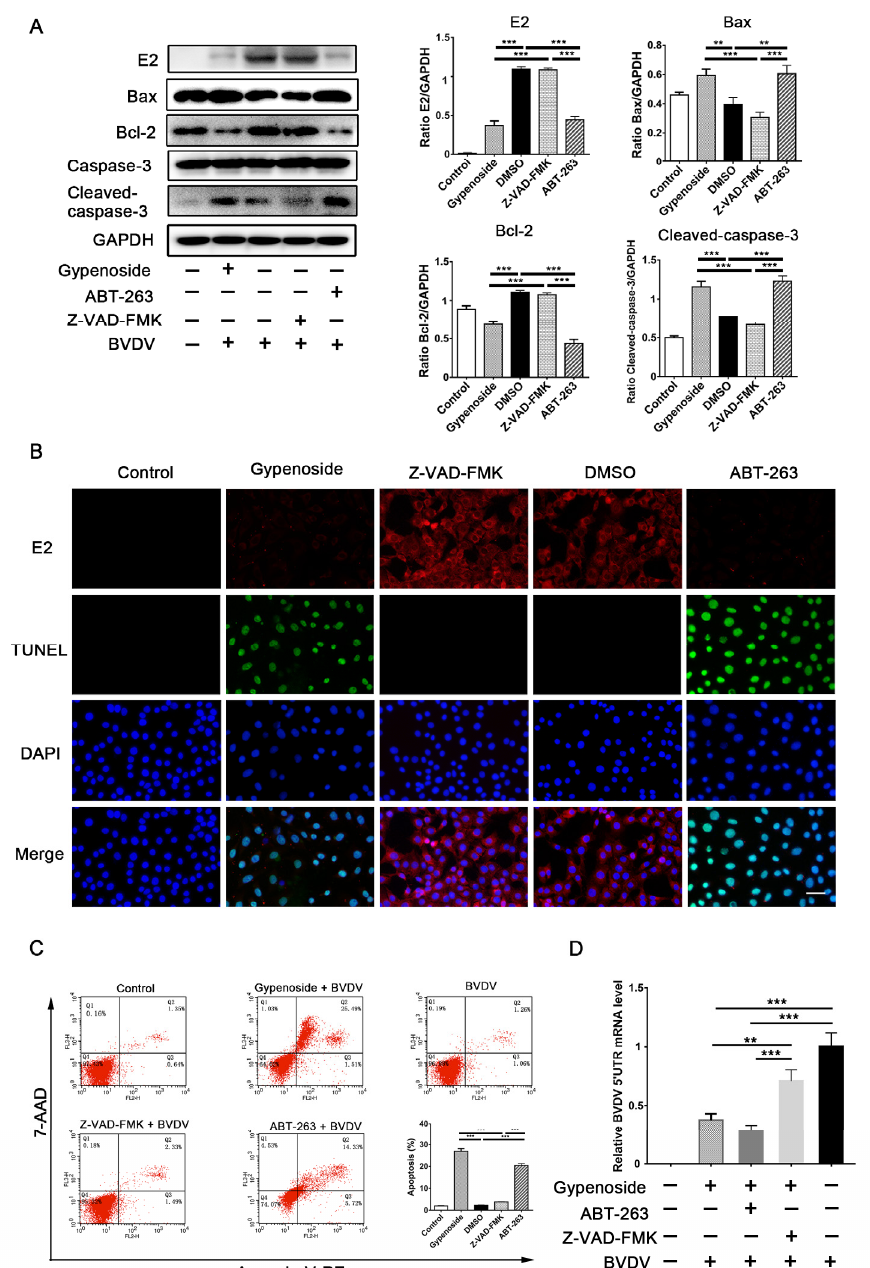
Figure 6. Apoptosis might be involved in the anti-BVDV mechanisms of gypenoside in MDBK cells. ( A ) Western blotting analysis of the BVDV E2, Bax, Bcl-2, and cleaved caspase-3 proteins in BVDV-infected MDBK cells treated with gypenoside, Z-DEVD-FMK, or ABT-263 at 24 hpi. The protein bands were quantified as the ratio of the intensity of the protein bands to that of the GAPDH band in Western blotting. ( B ) TUNEL and IFA staining were used to assess the effects of the treatments with gypenoside, Z-VAD-FMK, or ABT-263 on BVDV infections and apoptosis in MDBK cells at 24 hpi. BVDV E2 protein (red), TUNEL (green), and DAPI (blue). Scale bars represent 50 μ m. The merging represents the co-localization of red, green, and blue staining. ( C ) Flow cytometry analysis of apoptosis in BVDV-infected MDBK cells treated with gypenoside, Z-VAD-FMK, or ABT-263 at 24 hpi. ( D ) The expression of BVDV 5’UTR mRNA in BVDV-infected MDBK cells treated with Z-DEVD-FMK or ABT-263 in the presence of gypenoside at 24 hpi. Data from three independent experiments and error bars are presented as the mean ± SEM. ** p < 0.01, *** p < 0.001.